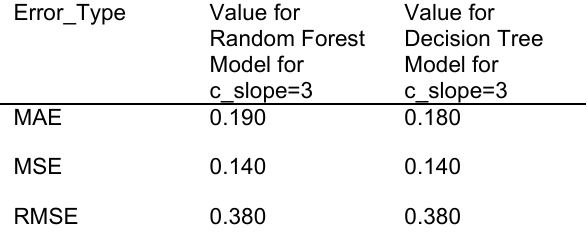
Table 4. Values of MAE, MSE, RMSE for overall data set for the Random Forest and Decision Tree Models